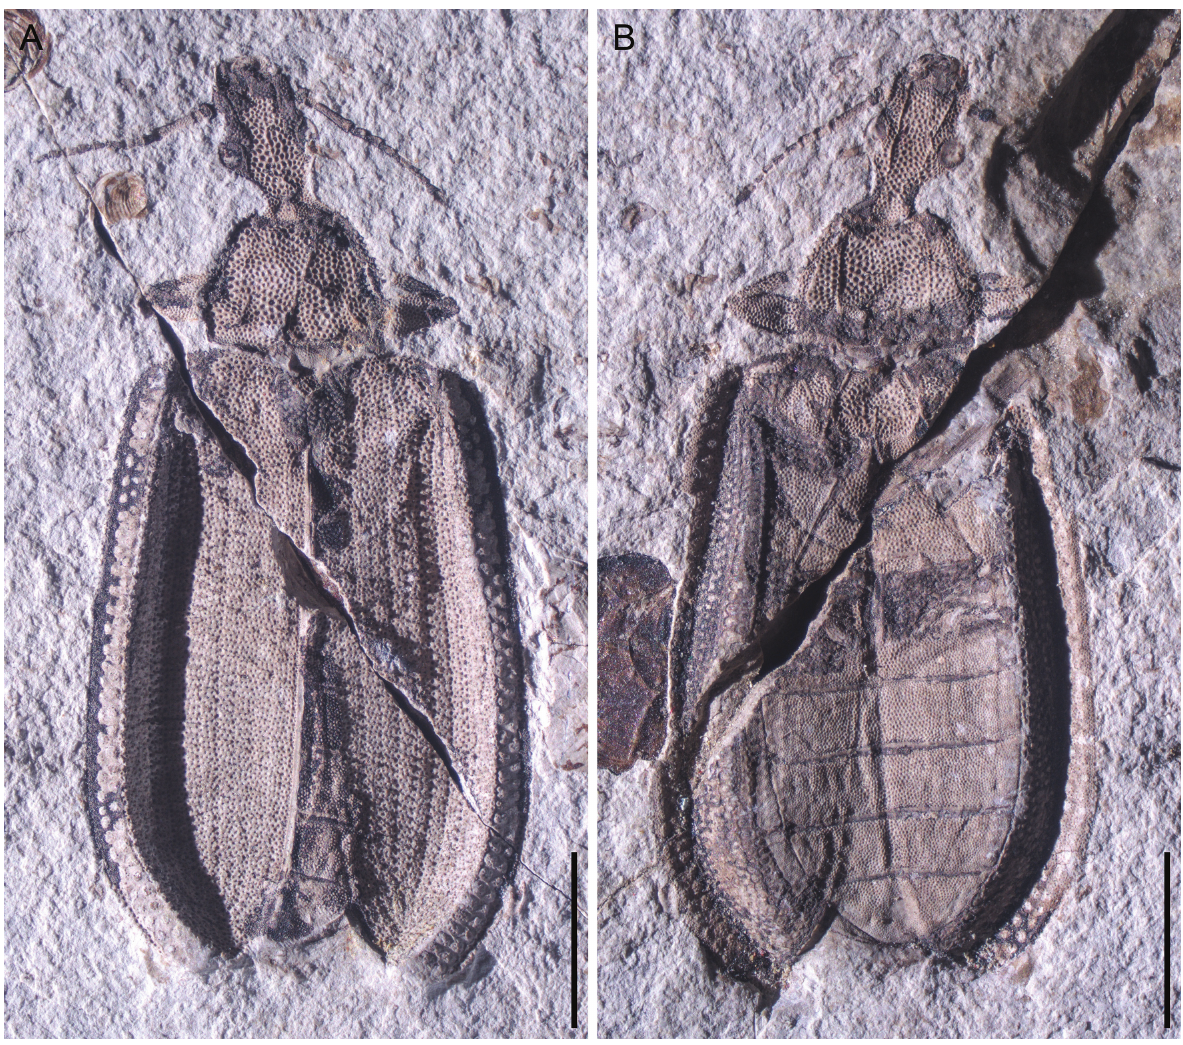
Figure 1. General habitus of Limnomma daohugouense gen. et sp. nov., holotype, NIGP176015, dry, under low-angle incident light. A. Part, NIGP176015a; B. Counterpart, NIGP176015b. Scale bars: 4